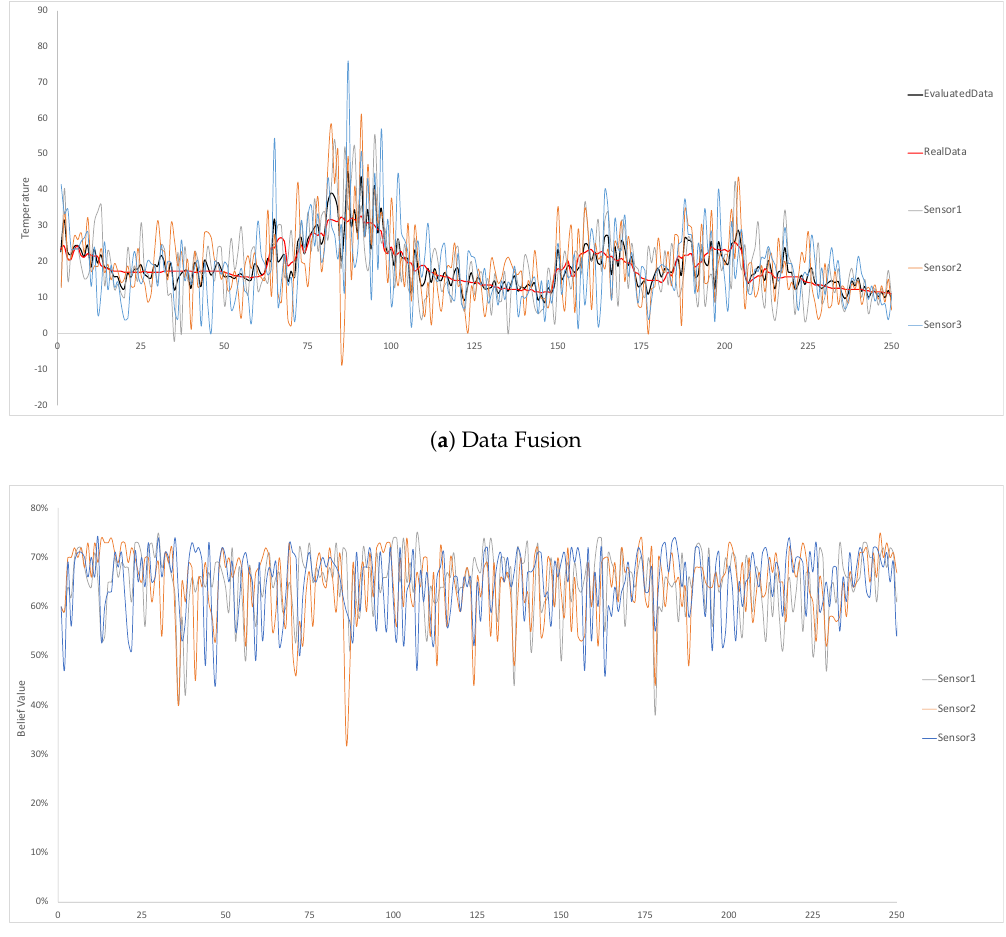
Figure 9. Three static temperature sensors at location 1 with 60% belief setting for each